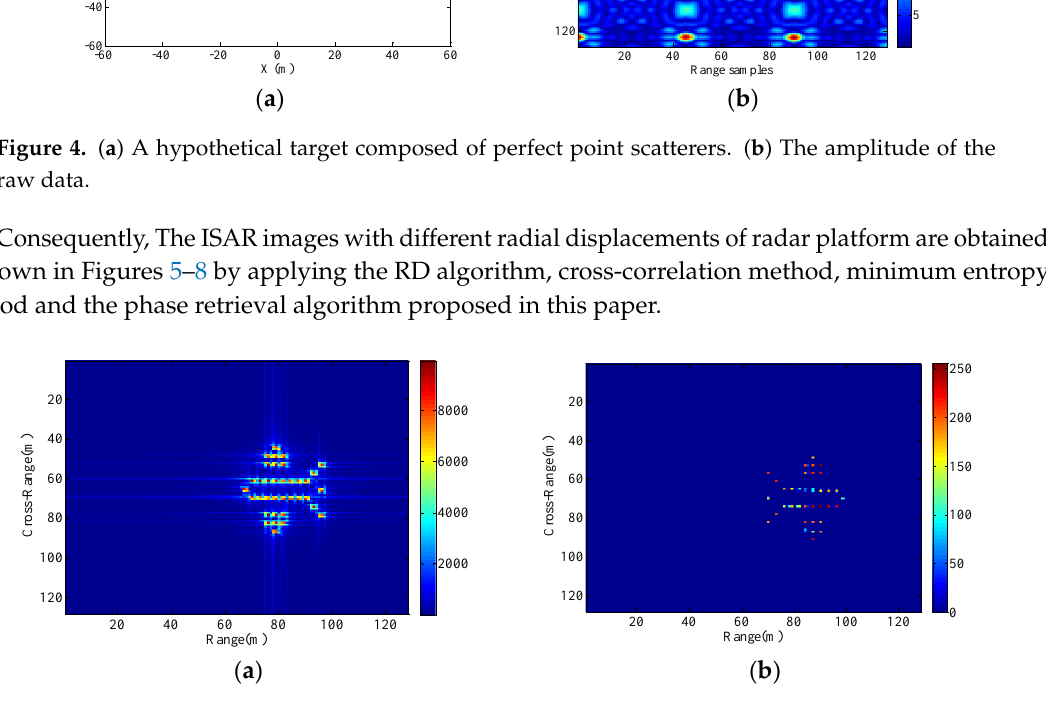
( d ) Figure 6. Imaging results with the radar platform displacement parameters P2. ( a ) RD algorithm; ( b ) cross-correlation method; ( c ) minimum entropy method; ( d ) the proposed method. ( a ) ( b ) Figure 7. Cont.